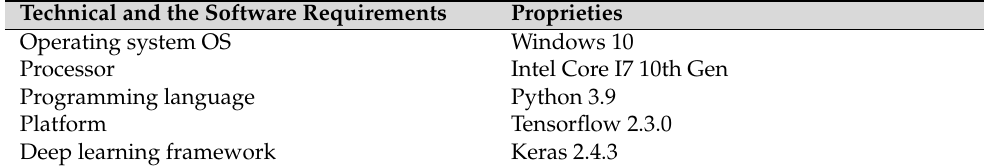
Table 6. Technical and software requirements.